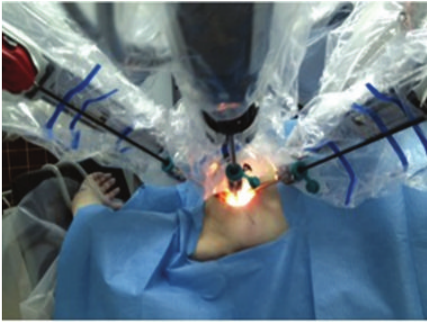
Figure 1: The picture showing setup position of the cadaver.